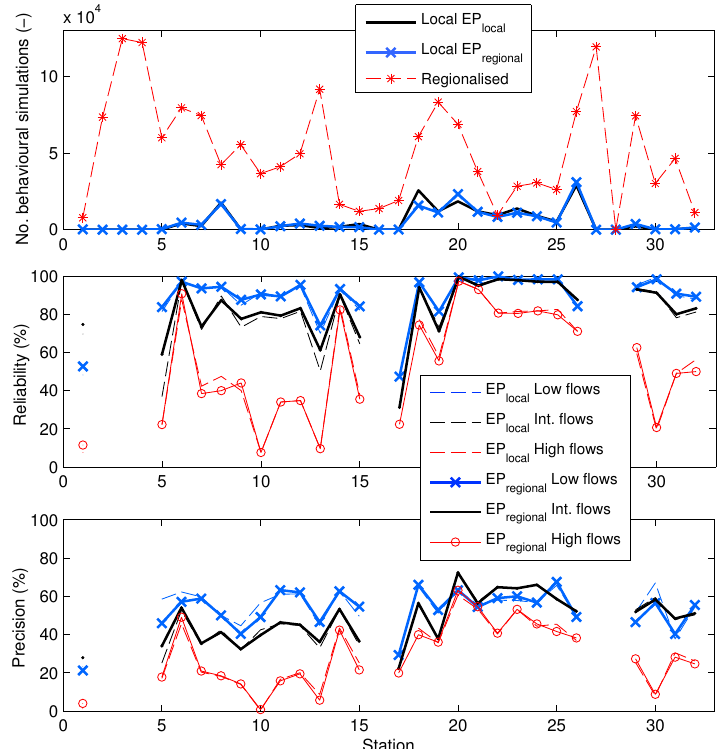
Figure 9. Number of behavioural simulations using local calibration to FDCs with local and regional EPs, and using regionalised FDCs (top panel), reliability (middle panel) and precision (bottom panel) measures for low, intermediate and high flows, for local and regional EPs respectively in local